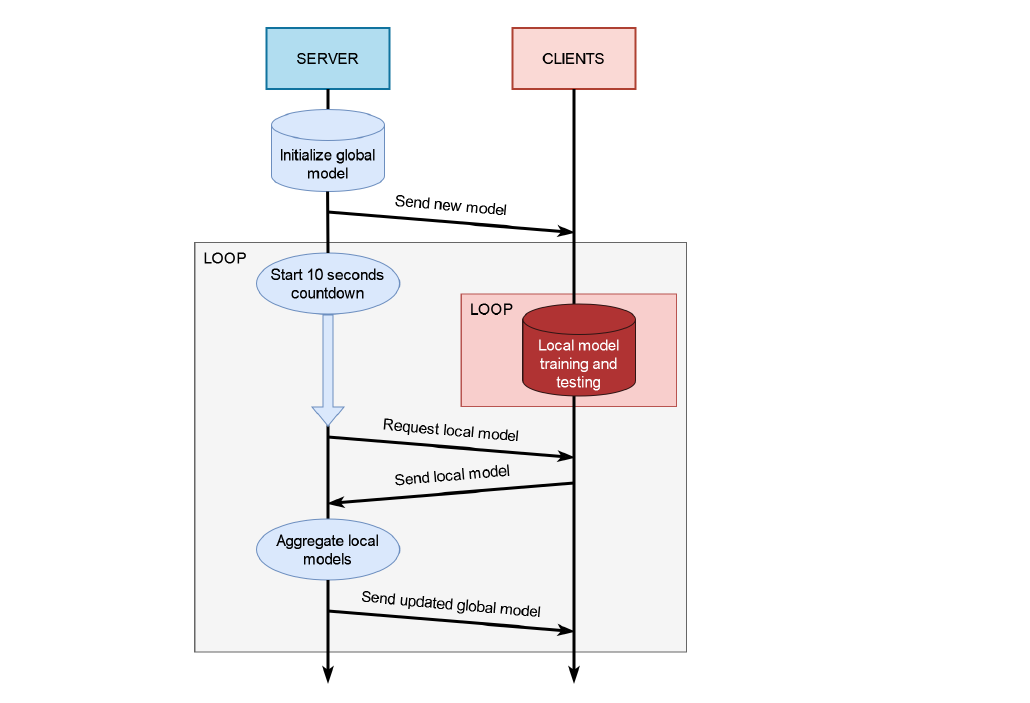
Figure 4. Sequence of interactions between server and clients in the federated learning